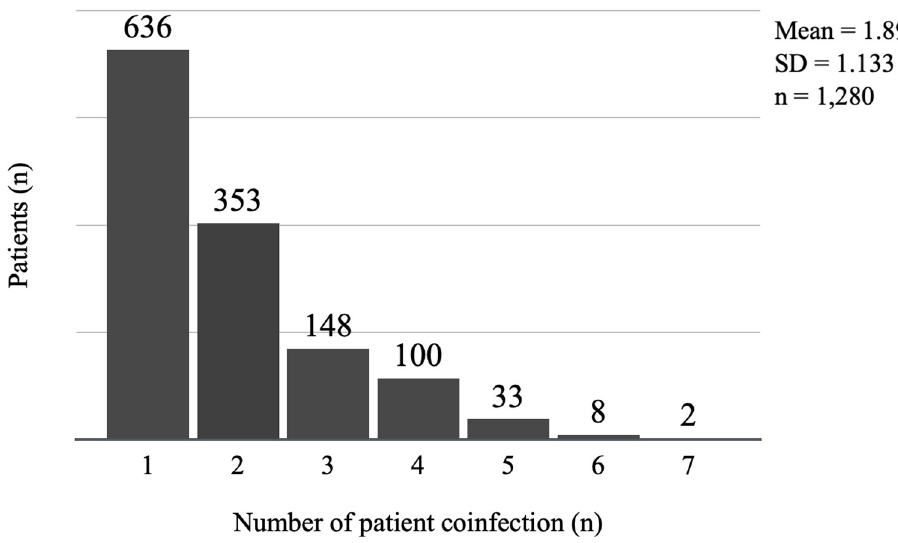
Fig 3. Distribution of concurrent infections on the